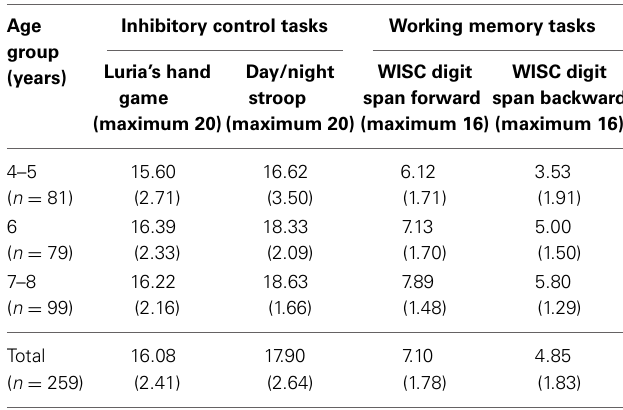
Table 2 | Mean number of accurate responses for executive function measures by age